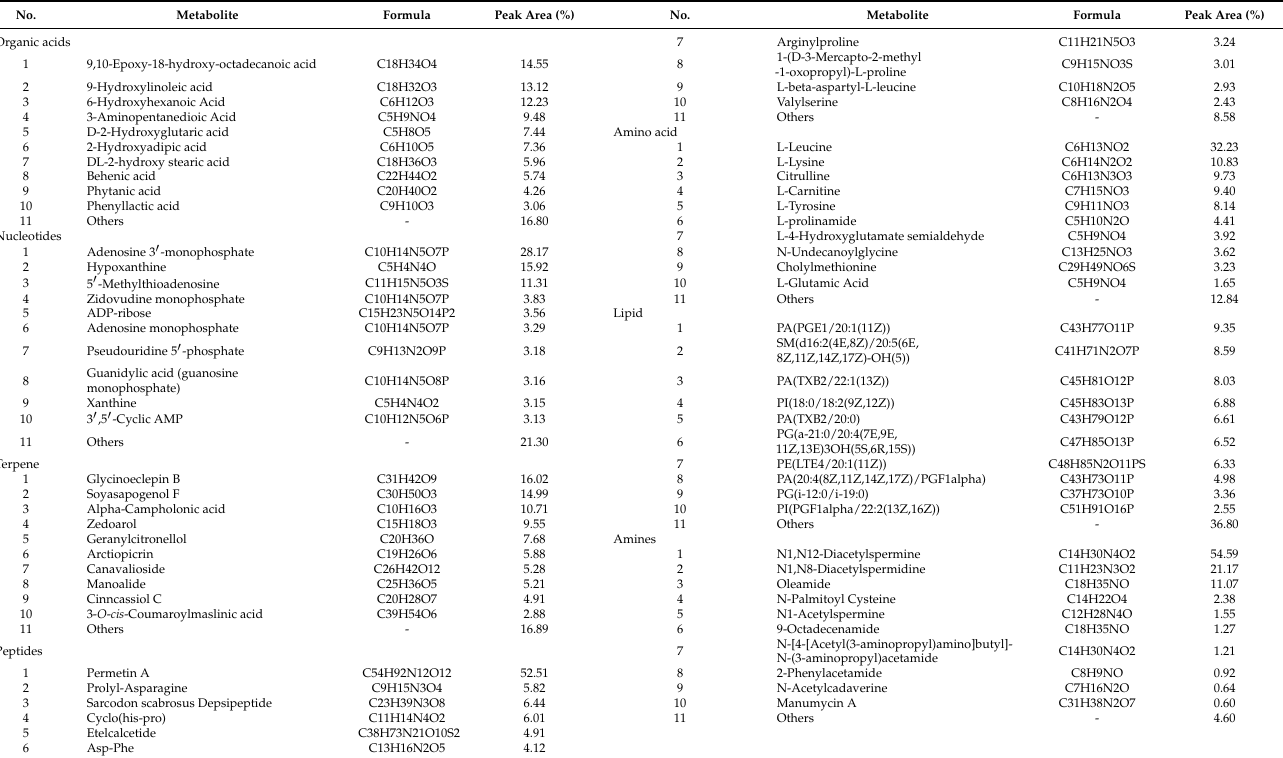
common in the nucleotides (Tables 1 and 2). Moreover, there was no common substance in the top 10 of terpenes and peptides between ET-22-HK and ET-22-S (Tables 1 and 2).